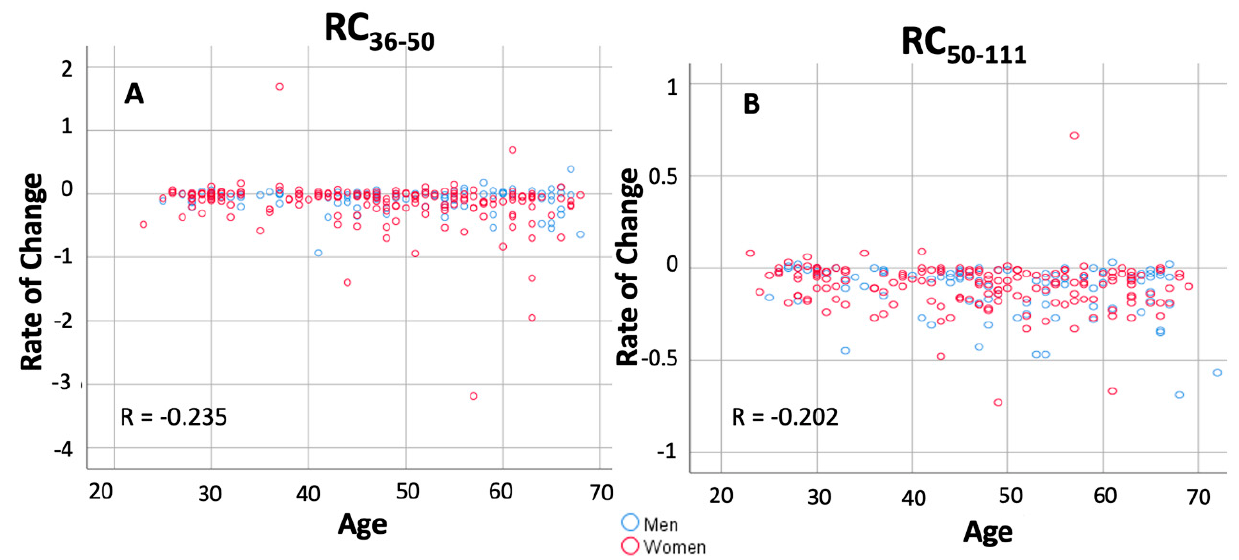
Figure 5. Correlation plots between the rate of change (RC) in the (%) inhibition of SARS-CoV-2 binding and the age of the individuals participated in the study. Age was found to significantly affect RC values for the time intervals 36–50 days (plot ( A ): RC 36–50, p = 0.01) and 50–111 days (plot ( B ): RC 50–111, p = 0.02). As RC values tend to be higher (in absolute term) values, the change in the % inhibition is greater. Blue circles refer to men, while red circles to women.